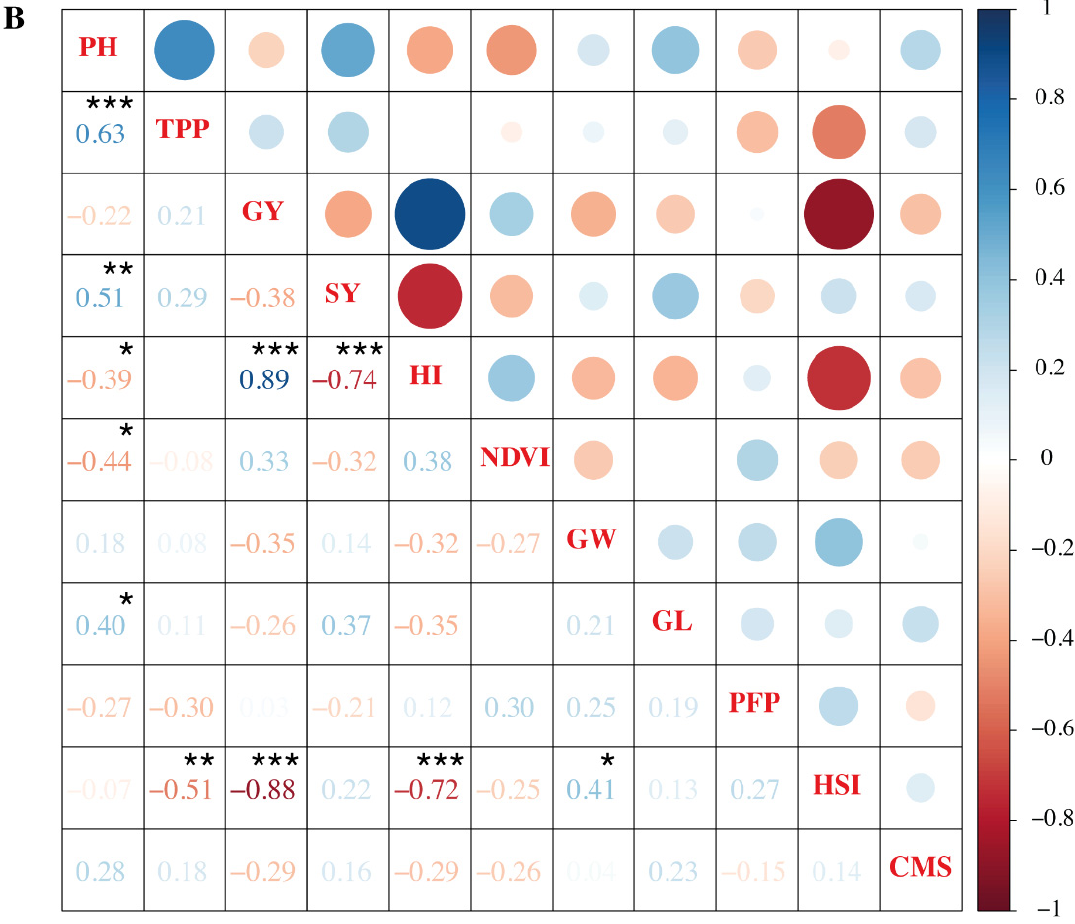
Figure 6. Association studies between agronomic parameters under control ( A ) and heat stress ( B ). PH = Plant height (cm), TPP = Tillers per plant, GY = Grain yield per plant (g), SY = Straw yield per plant (g), HI = Harvest index, GW = 1000-Grain weight (g), GL = Grain length (mm), NDVI = Nor- malized difference vegetative index, PFP = Pollen fertility percentage, his = Heat susceptibility in- dex, and CMS = Cell membrane stability. * p < 0.05, ** p < 0.01, and *** p < 0.001.